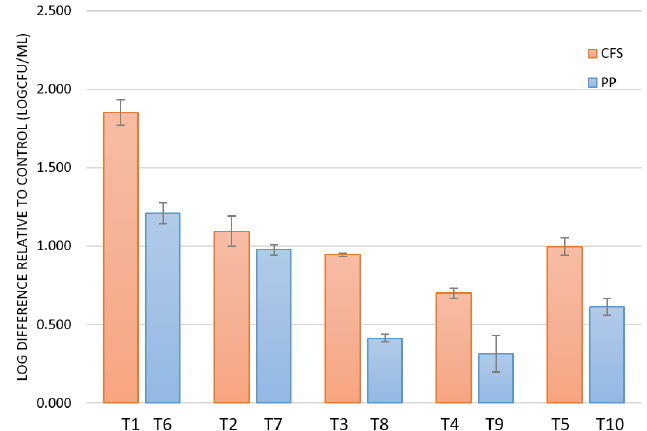
Figure 1. Log difference in cell viability between cell-free supernatant (CFS) peptide-containing formulations and precipitated peptide (PP)-base formulations relative to control (positive, cocktail only) without peptide added. Legend: T1: CFSCys5-4/CFSGt28:1:1 (v/v); T2: CFSCys5-4/CFSGt28:1:3